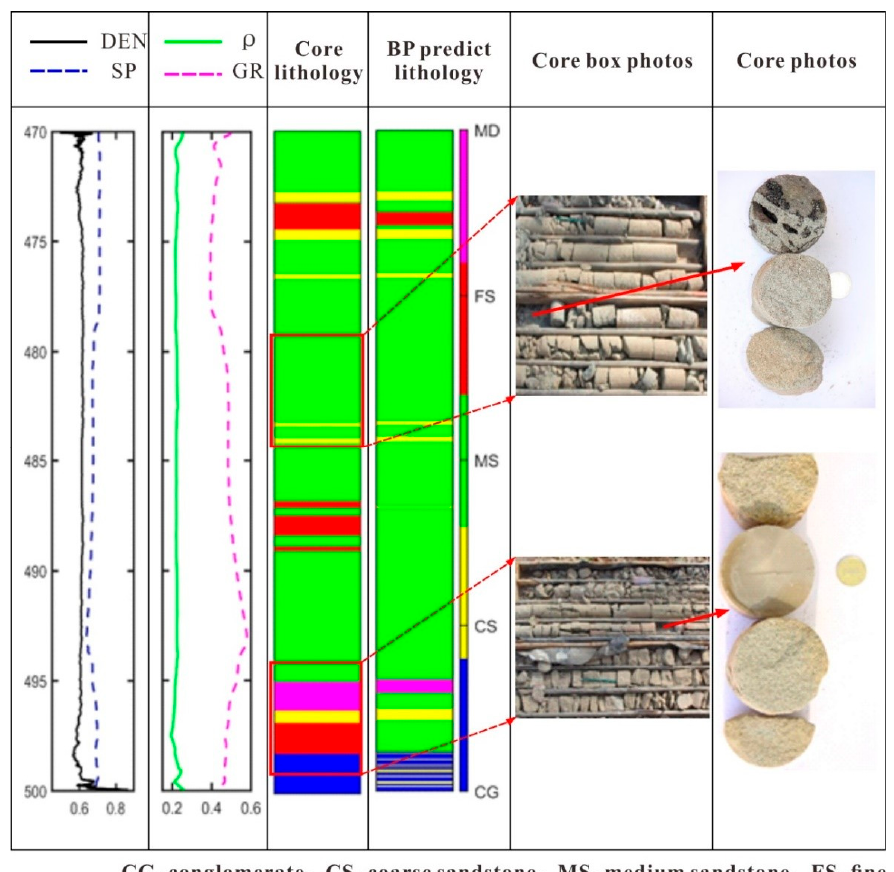
Figure 12. Comparison between predicted lithology and core logging of borehole ZKC240-87. CG— conglomerate, CS—coarse-grained sandstone, MS—medium-grained sandstone, FS—fine-grained sandstone, KS—calcareous sandstone,